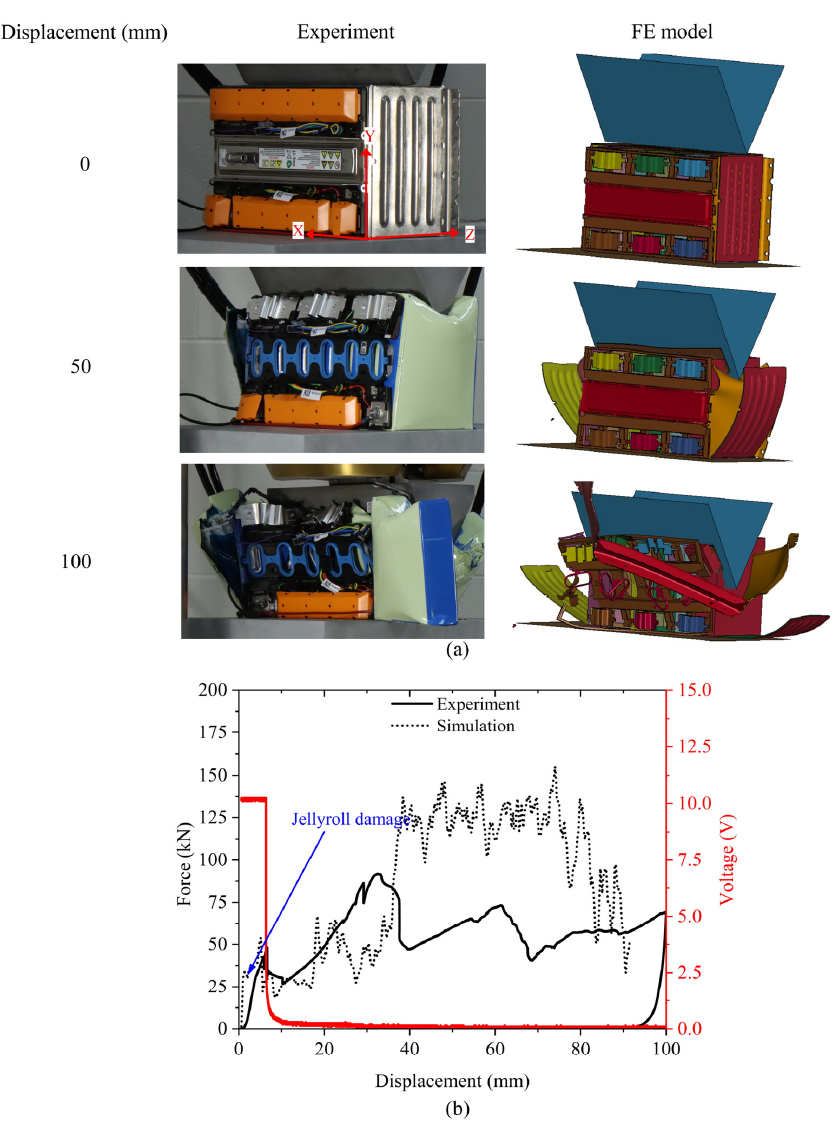
Figure 5. Experimental and FE model simulation for Case 2 (0.05 mm/s quasi-static indentation of battery module along y direction with wedge edge parallel to x direction): ( a ) Module deformations; ( b ) Force-displacement responses (black) and experimental voltage responses (red).